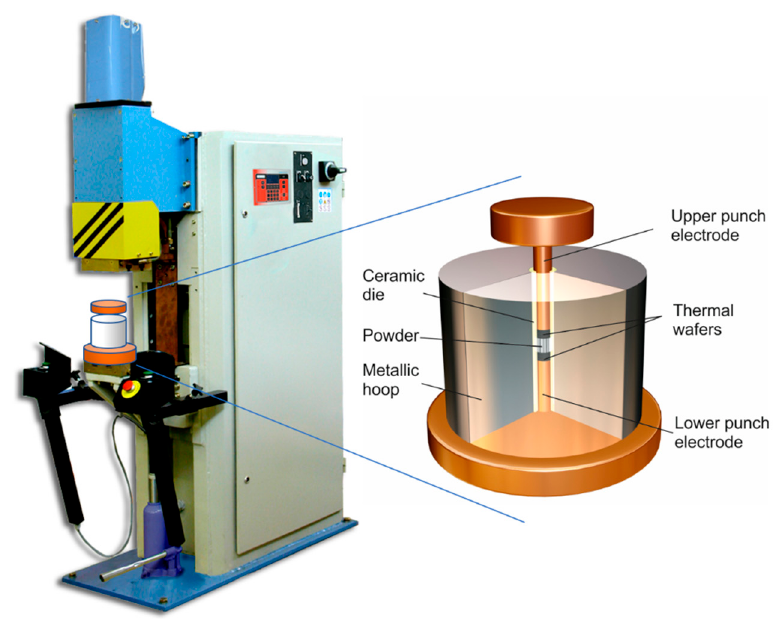
Figure 1. Electrical resistance welding machine adapted to act as the MF-ERS equipment, and sketch of the die and electrodes set employed in the experiments.